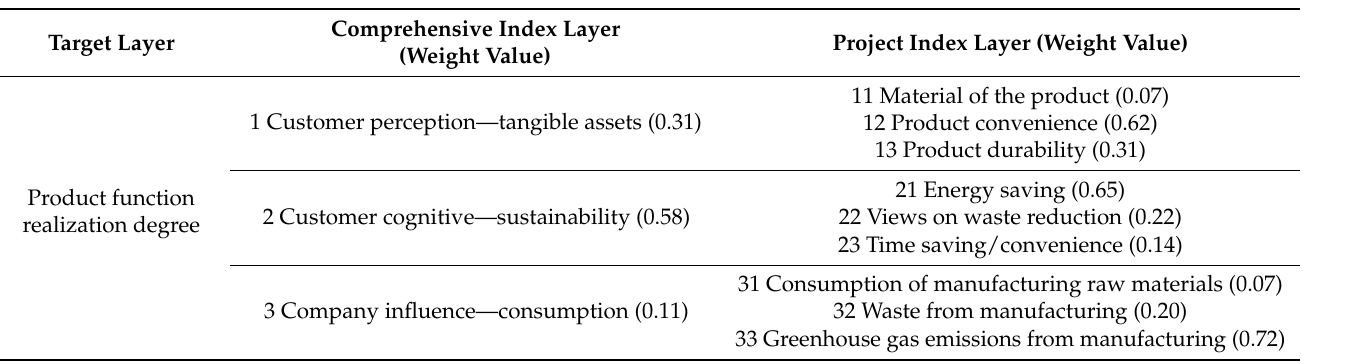
Table A2. The evaluation index system.